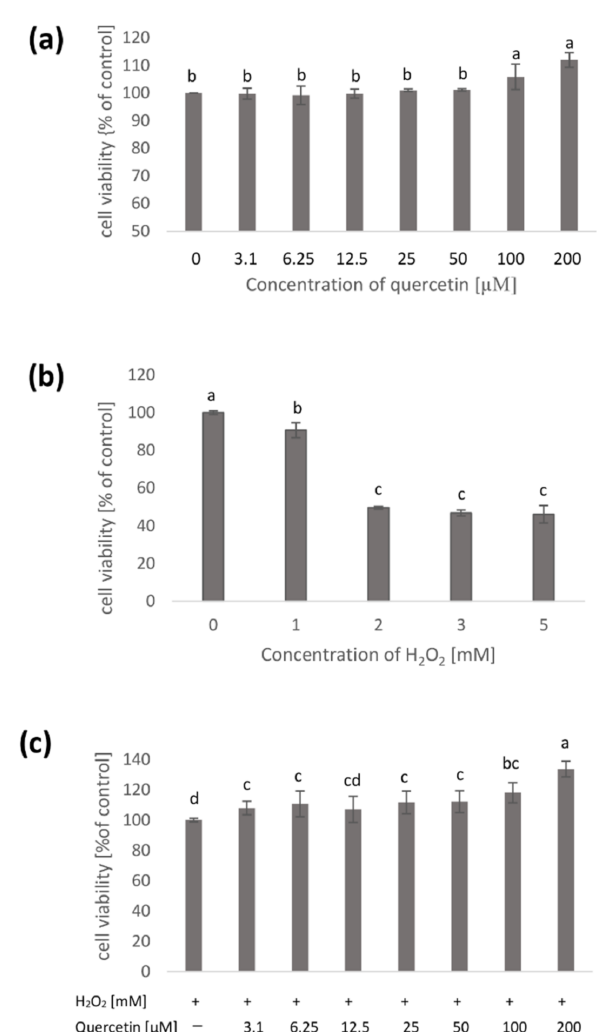
Figure 1. The cell viability was determined by MTT assay. SK-N-SH cells were exposed for 24 h to various concentrations of quercetin (3.1–200 µ M). The percentage of cell viability was referred to the untreated control cells ( a ); cells contacted for 3 h with various concentrations of H 2 O 2 (mM) ( b ), SK-N-SH cells preincubated for 24 h with different concentrations of quercetin and then contacted for 3 h with H 2 O 2 . The percentage of cell viability was related to cells treated only with H 2 O 2 ( c ). Values represent mean ± SD of three to six independent experiments. Different letters indicate significant differences ( p ≤